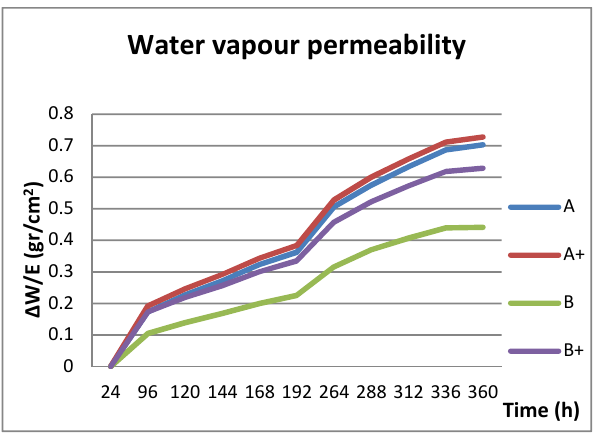
Figure 3. Water vapor permeability curves.